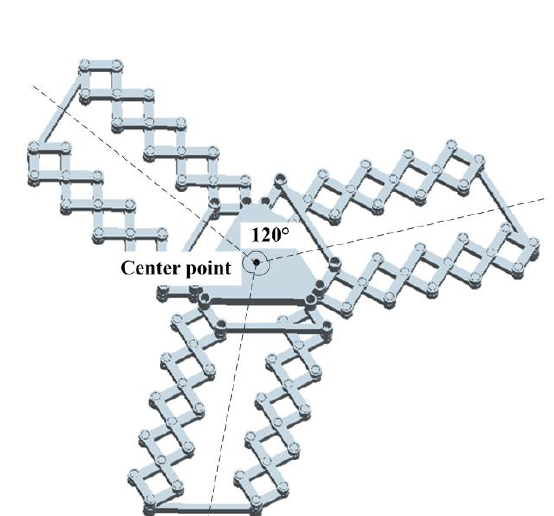
Figure 4. Two-DOF translational parallel